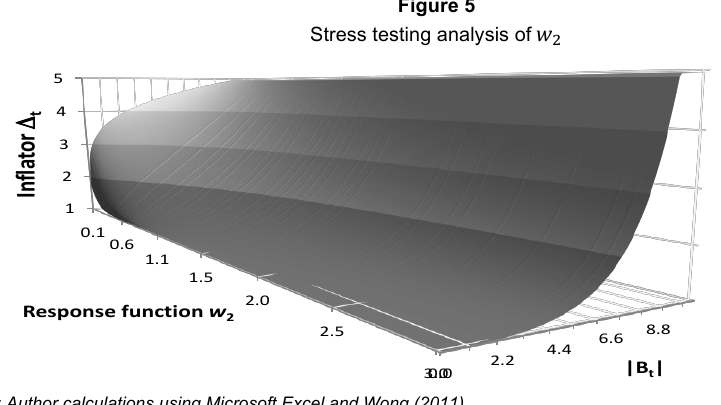
Figure 5 Stress testing analysis of 𝑤